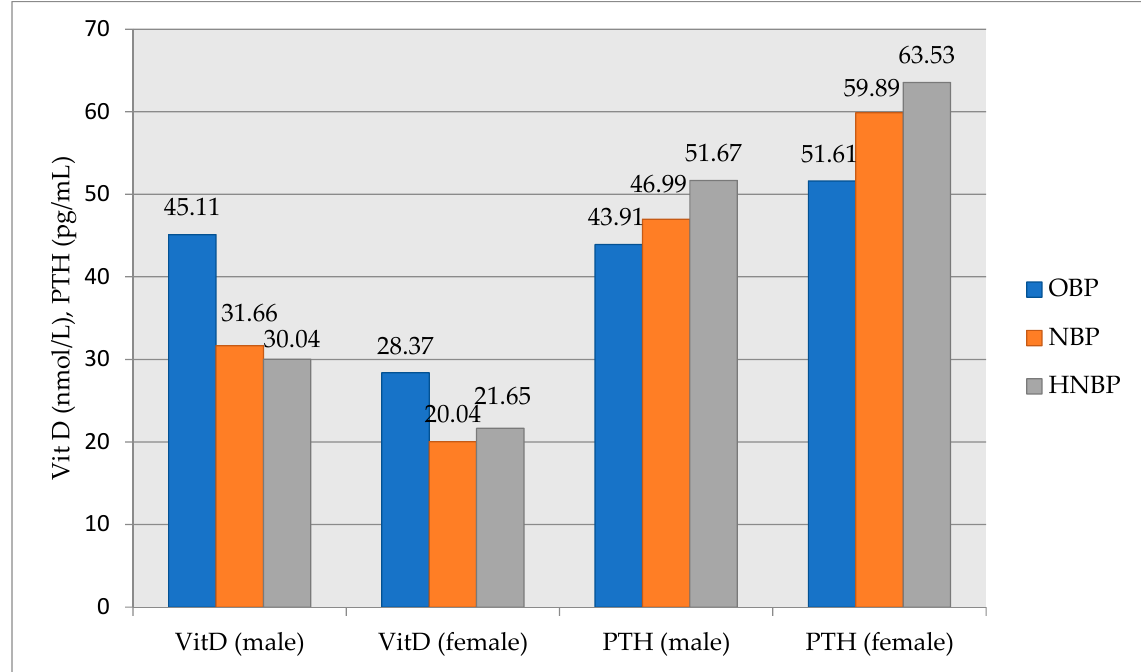
Figure 3. Comparison of vitamin D and PTH levels between groups (OBP and NOBP) by gender. OBP, optimal blood pressure; NOBP, non-optimal blood pressure; VitD, vitamin D; PTH, parathyroid hormone.